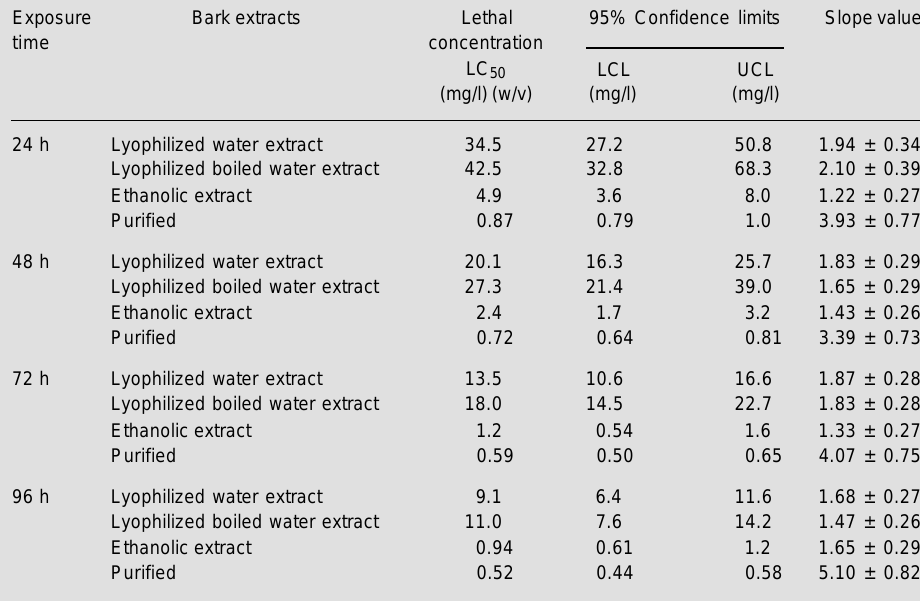
Table 1 - Toxicity of Nerium indicum bark against the snail Lymnaea acuminata. Batches of 10 snails were exposed to different extracts of Nerium indicum bark and column-purified ethanolic extract. Mortality was determined every 24 h. Each set of experiments was replicated six times. The values are the final concentrations (w/v) in the glass aquarium water. The product moment correlation coefficient showed a significant (P<0.05) negative correlation between exposure time and different LC 50 values. The t- ratio was >1.96, heterogeneity factor was <1.0, and the g value was <0.5 at all probability levels. LCL, Lower confidence limit; UCL, upper confidence limit. Slope value is reported as mean ± SEM.